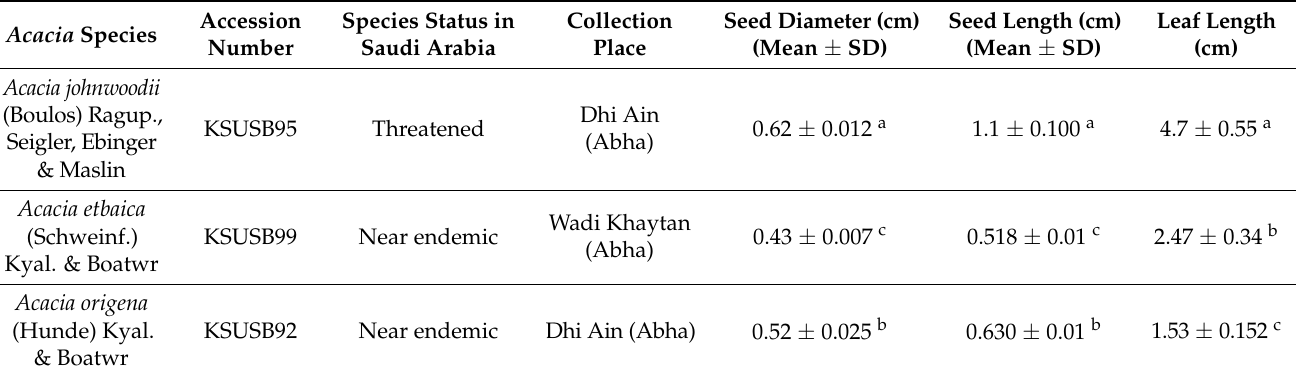
Table 1. Acacia species status, collection place, seed size and leaf size (plant grown in a pot in a growth